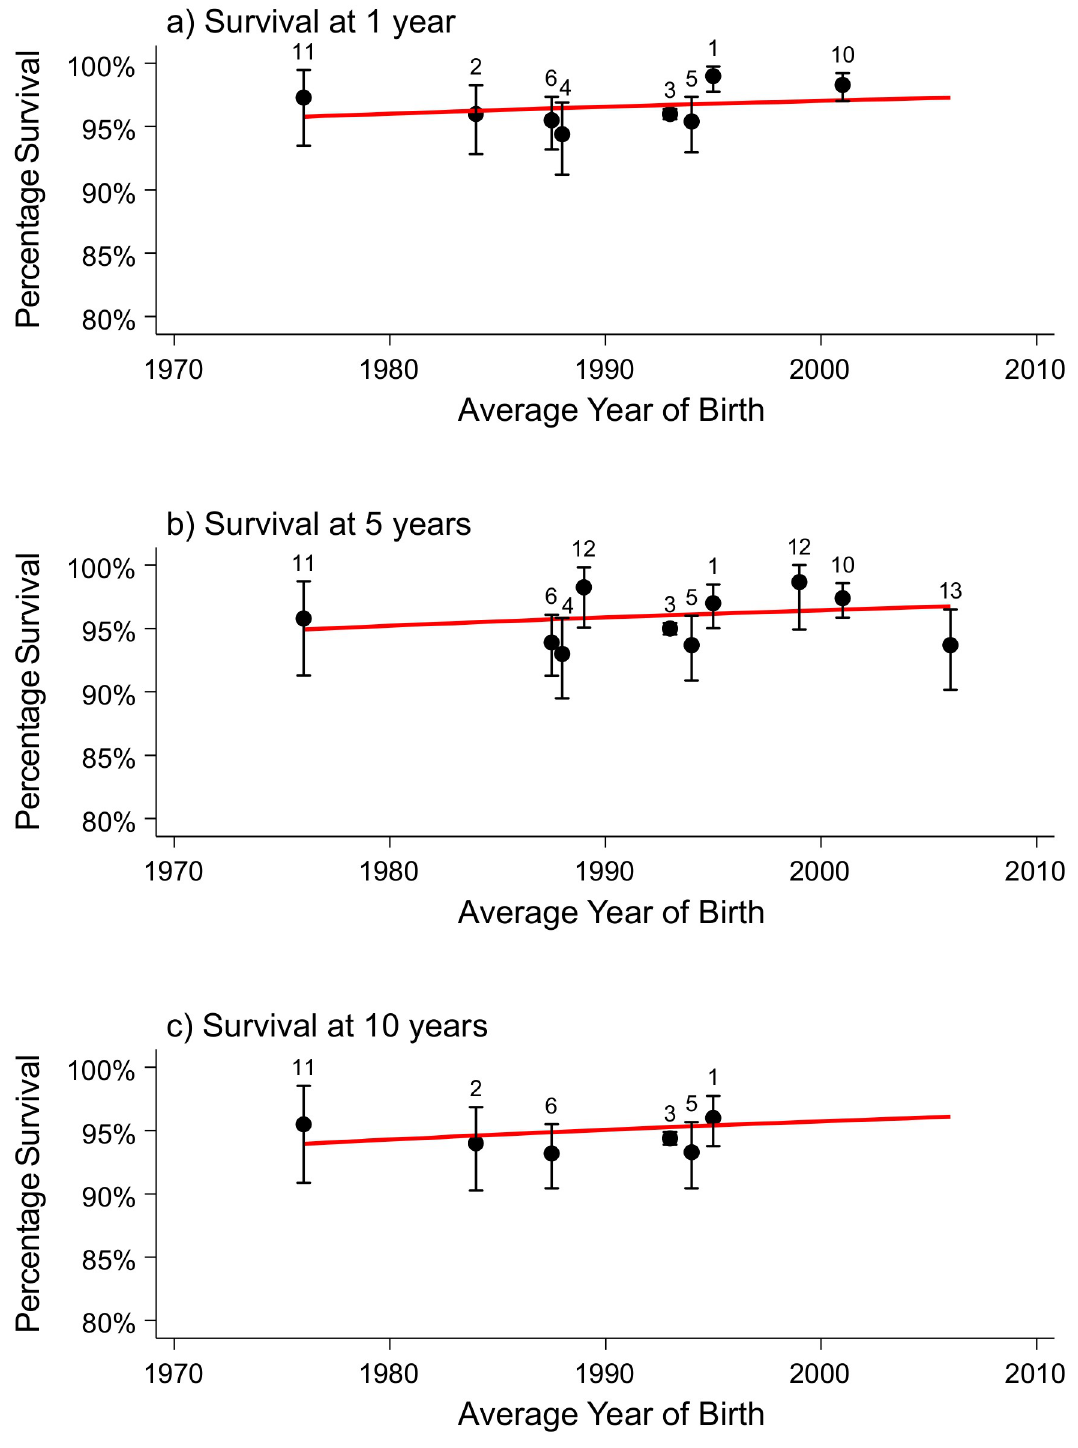
Fig 8. Survival estimates (with 95% confidence intervals) of children with Down syndrome without congenital heart defect at 1 (a), 5 (b), and 10 (c) years of age over time (11 birth cohorts from 10 studies). The numbers at survival points indicate the included study, which may appear more than once if survival was reported for more than one birth cohort: 1 –Glasson, 2016, Western Australia; 2 –Hayes, 1997, Ireland; 3 –Kucik, 2013, USA; 4 –Leonard, 2000, Western Australia; 5 –Rankin, 2012, Northern England; 6 –Rasmussen, 2006, Atlanta, USA; 10 –Brodwall, 2018, Norway; 11 –Frid, 1999, northern Sweden; 12 –Halliday, 2009, Victoria, Australia, 13 –Schneuer, 2019, New South Wales,